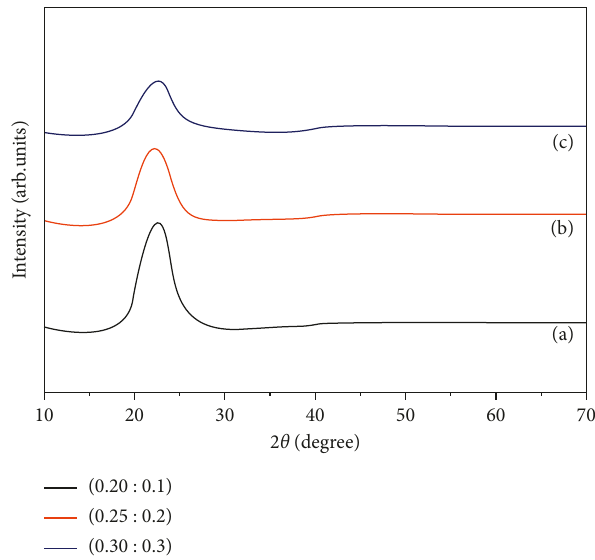
Figure 1: XRD analysis of polymer electrolyte films for different PVP/PVA : GO wt.% ratios of (0.20 : 0.1), (0.25 : 0.2), and (0.30 :